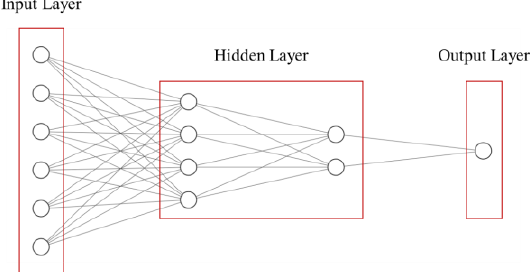
Figure 1. An example of ANN architecture, which consists of 1 input layer, 2 hidden layers, and 1 output layer.